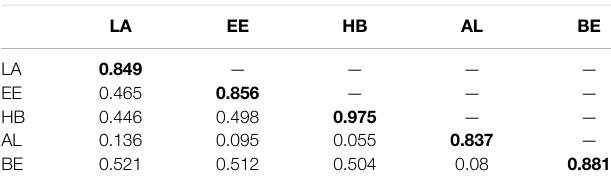
BE 0.521 Bold values show the square root of AVE in the